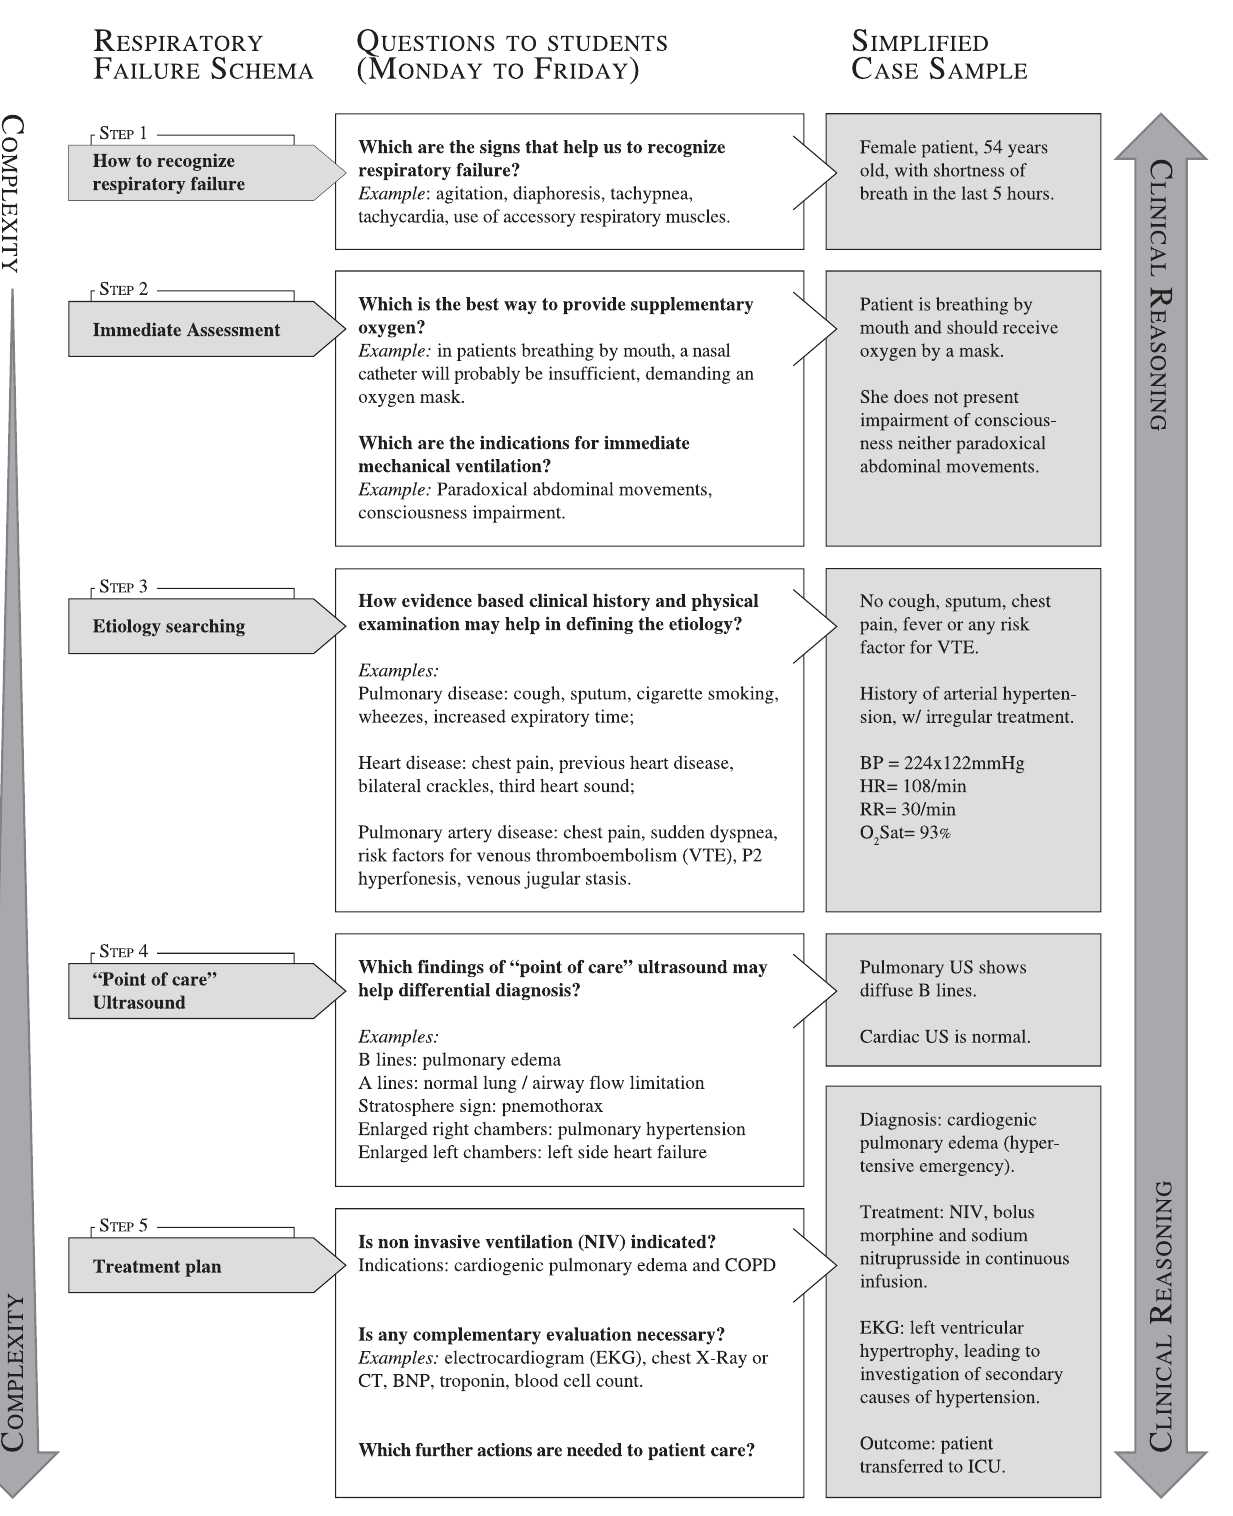
Fig 1. Virtual Rounds case construction — Respiratory Failure. At left, a schema is shown in six successive steps, discussed during the week. In general, one or two steps are discussed in a single day, from Monday to Friday. The following steps were addressed only after the previous had been accessed. At right, we provide a resumed Virtual Round model, with the main information that would be discussed at the online shared forums with students, having the schema as a guide.